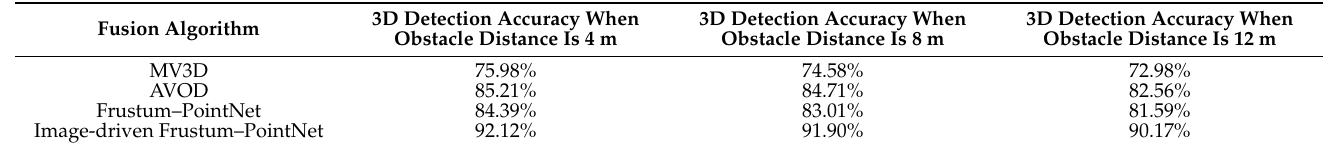
Table 7. Comparison of 3D detection accuracy of different fusion algorithms.